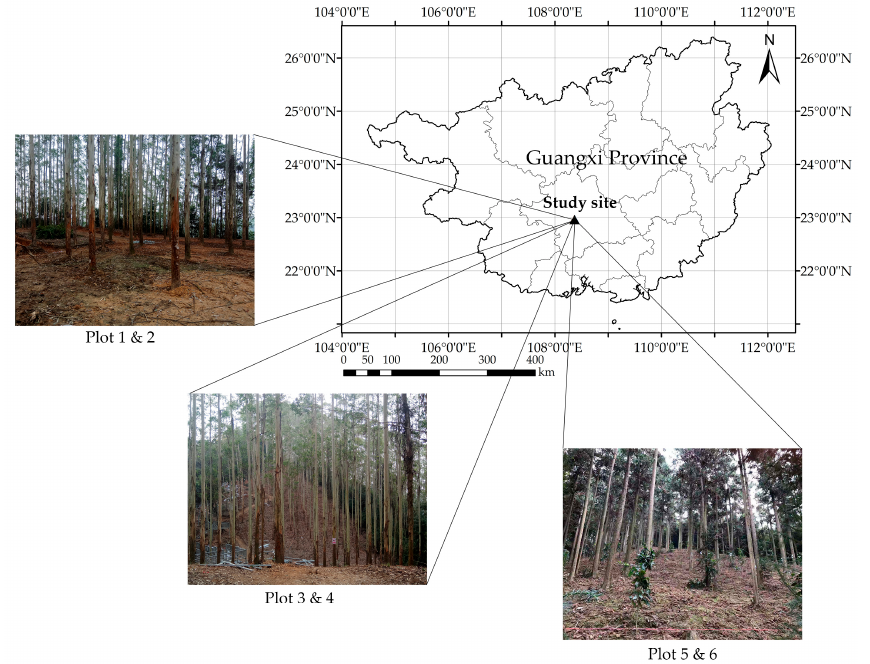
Figure 1. Location of the study area.